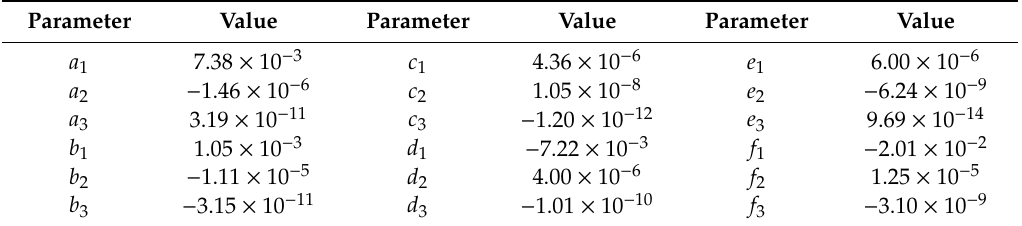
Table 1. Parameters of the coe ffi cients of the mathematical models for lateral geometric error correction.